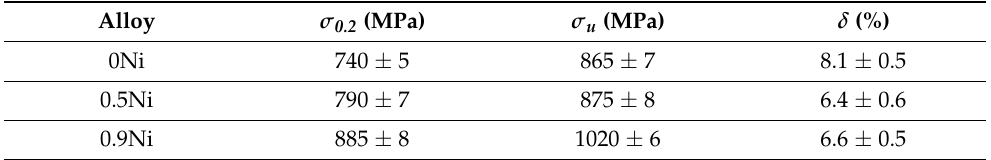
Table 2. Yield strength ( σ 0.2 ), ultimate tensile strength ( σ u ), and elongation to failure ( δ ) of the investigated alloys after superplastic deformation at 775 ◦ C and 0.69 true strain (100% engineering strain) after quenching and